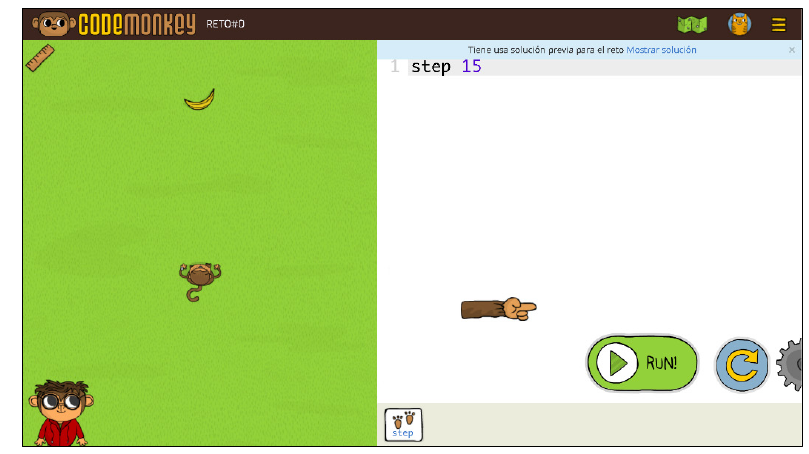
Fig. 2. Interface with the Code Adventure game in